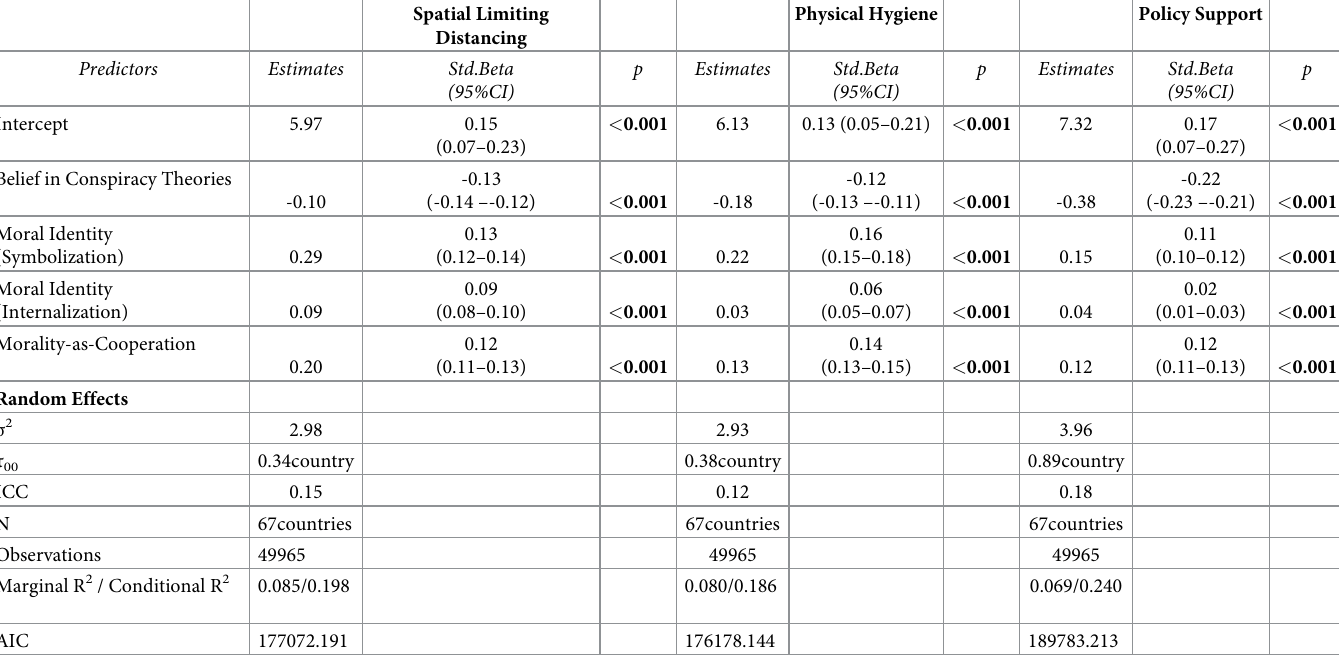
Table 2. Linear mixed effects